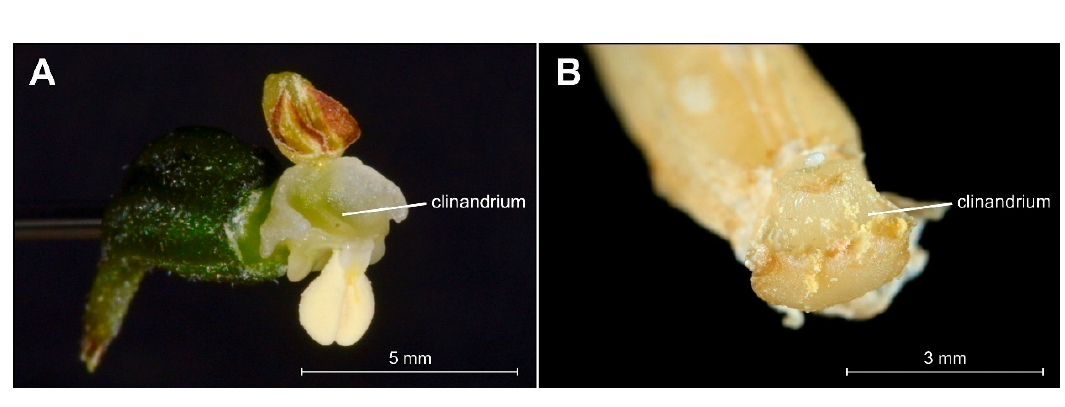
Figure 6. Comparison of details of clinandrium, i.e., the cavity in the upper part of the column that contains the anthers in Epipactis helleborine ( A ) and Epipactis greuteri (from material preserved in alcohol) ( B ).